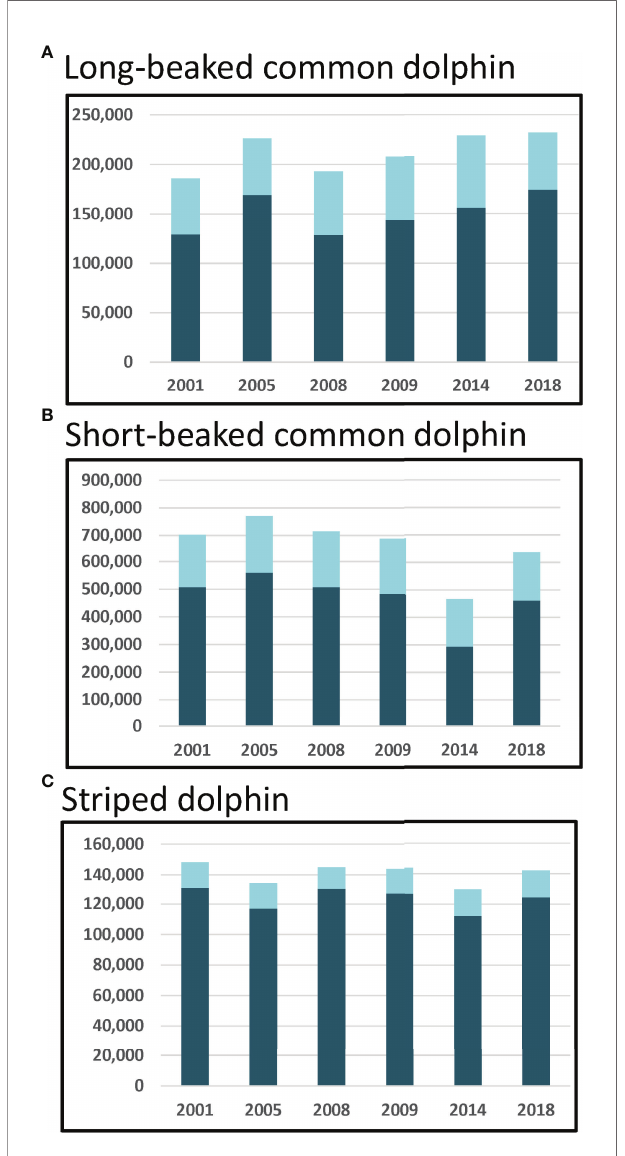
FIGURE 2 | Total yearly abundance for the two strata north of 32°N (light blue) and the four strata south of 32°N (dark blue) as predicted from the 1992 – 2018 habitat-based density models for (A) long-beaked common dolphin, (B) short-beaked common dolphin, and (C) striped dolphin. Strata are shown in Figure 1